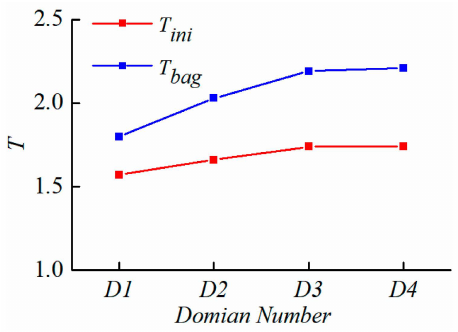
Figure 3. Comparison of droplet breakup time under various domain